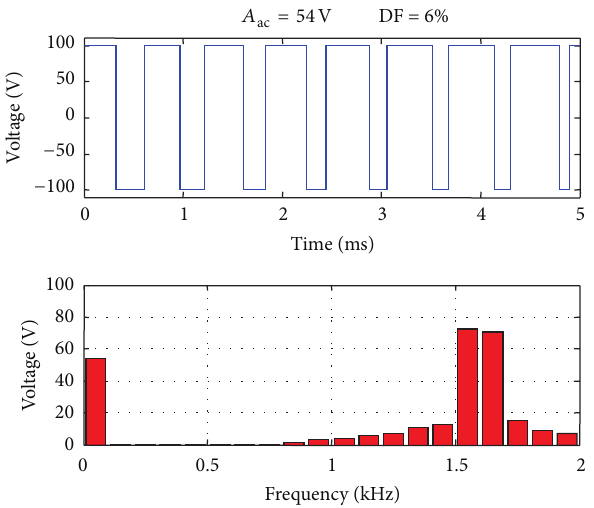
Figure 10: Advanced design with 𝑀 = 32 switching cycles. PWM = signal and harmonic distribution corresponding to the switching ac = 100 V. index system 𝐽 (𝑑) 32 = [3 : 4 : 127] , for a fundamental frequency of dc = 𝐴 = 100 50 Hz and 𝑉 dc ac